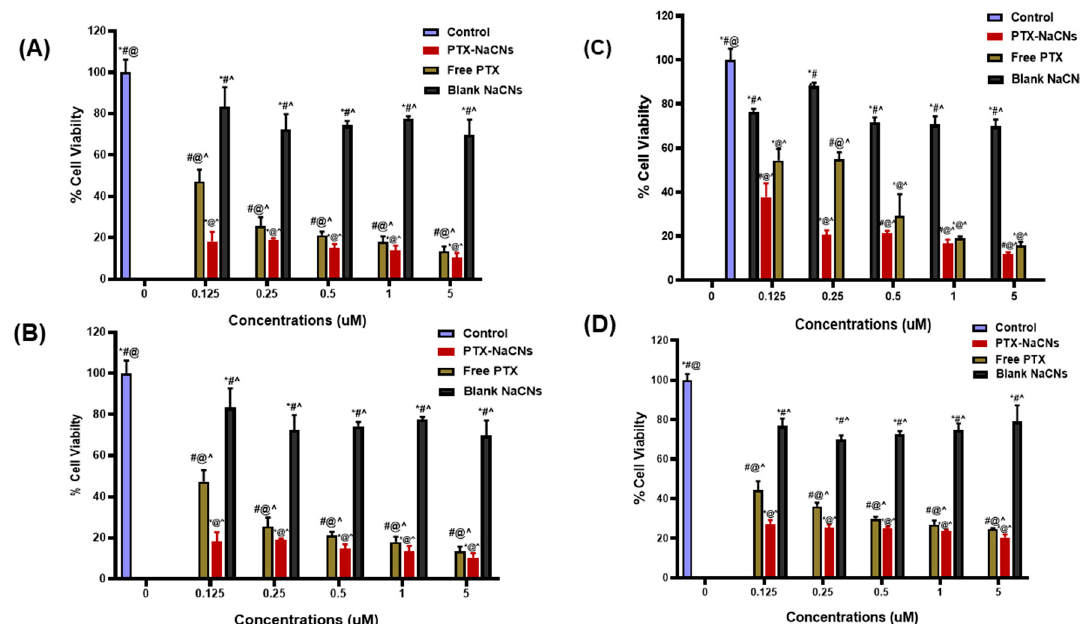
Figure 13. In vitro cell viability analysis through MTT assay following exposure of free PTX, PTX-NaCNs and blank micelles to ( A ) MCF-7 24 h ( B ) MCF-7 48 h ( C ) MDA-MB 231 24 h and ( D ) MDA-MB 231 48 h cell lines at 0.125–5.000 μ M after 24 h and 48 h incubation. Data are shown as mean ± S.D. where n ≥ 3 and ^ p < 0.0001 vs. control (media), @ p < 0.0001 vs. Blank micelles, * p < 0.0001 vs. Free PTX, # p < 0.0001 vs. PTX-NaCNs.